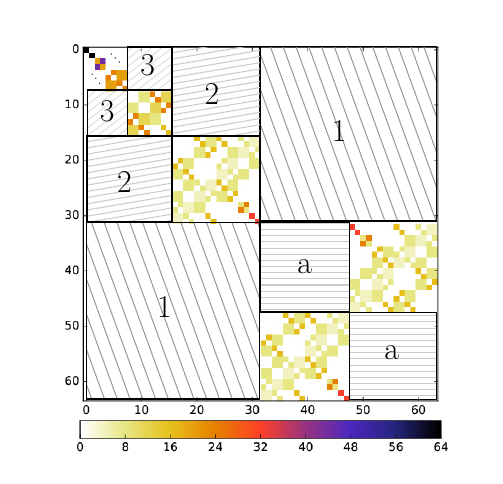
Figure 20: The ddt of x 7→ R (3 × R ( x )) in Z / 64 Z . The hatched squares define impossible transitions that can be easily